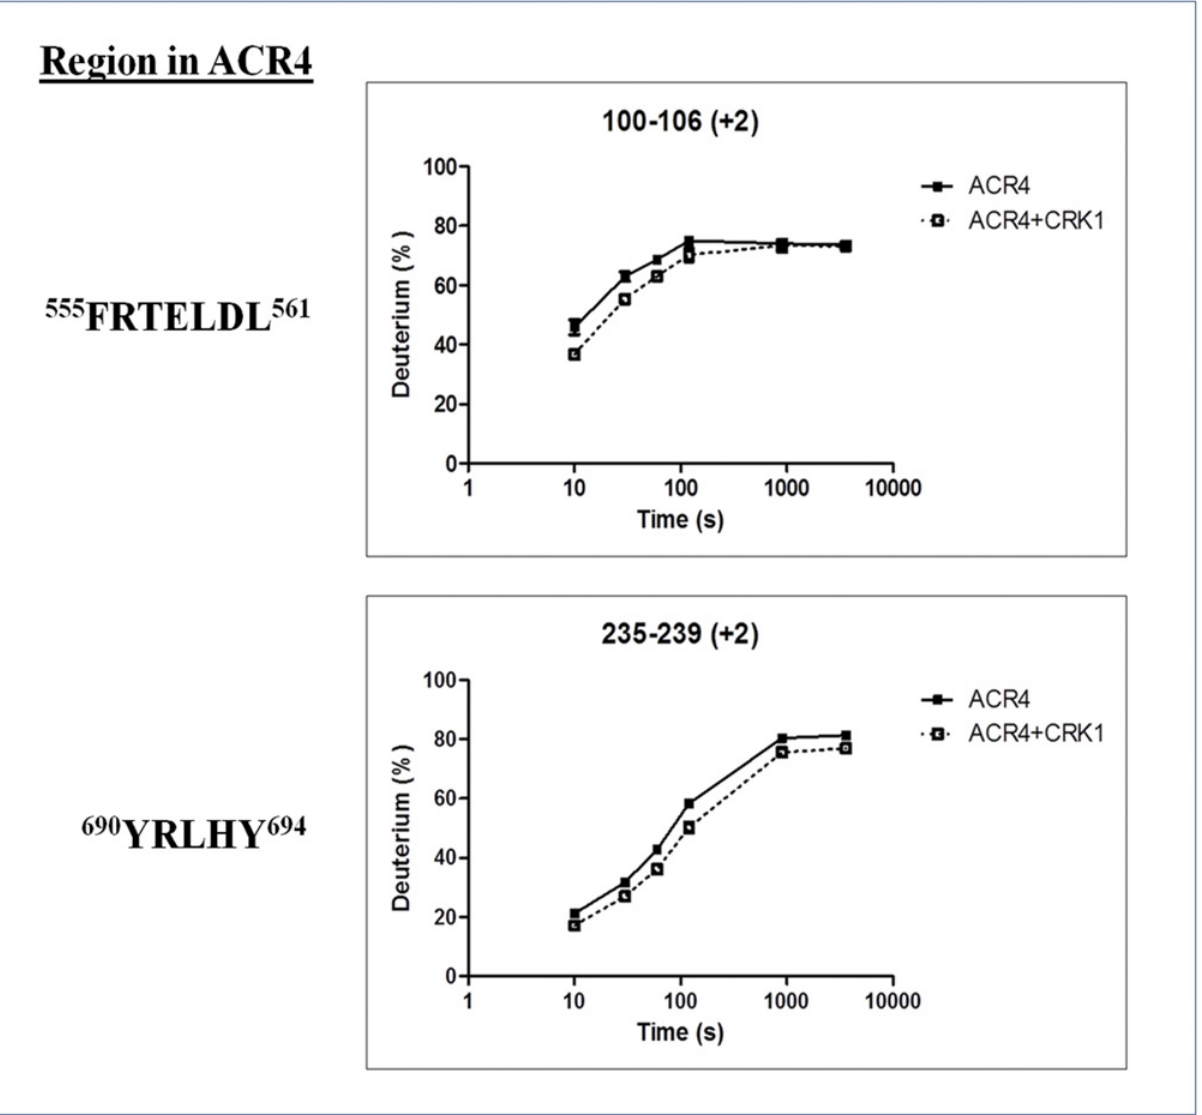
Fig 4. HDX-MS analysis of ACR4/CRK1. Time course of deuterium uptake for two ACR4 peptides, FRTELDL and YRLHY, that demonstrated significant hydrogen-deuterium exchange rates between the free ACR4 (closed squares) and the ACR4/CRK1 bound (open squares) states. Data represent the mean (n =